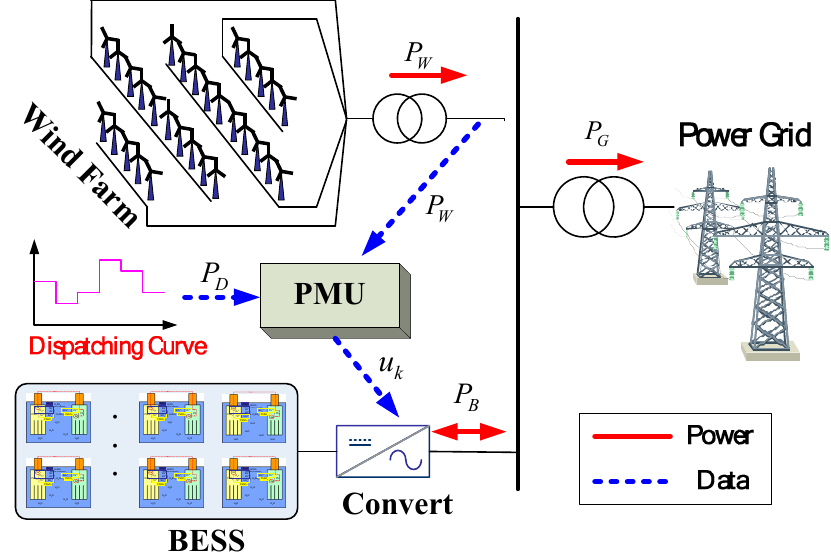
Figure 1. Structure chart of wind/battery energy storage hybrid system.